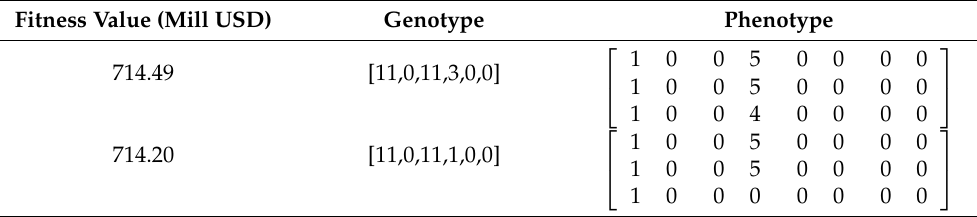
Table 11. Solutions found for the cases starting with POP20 R2.